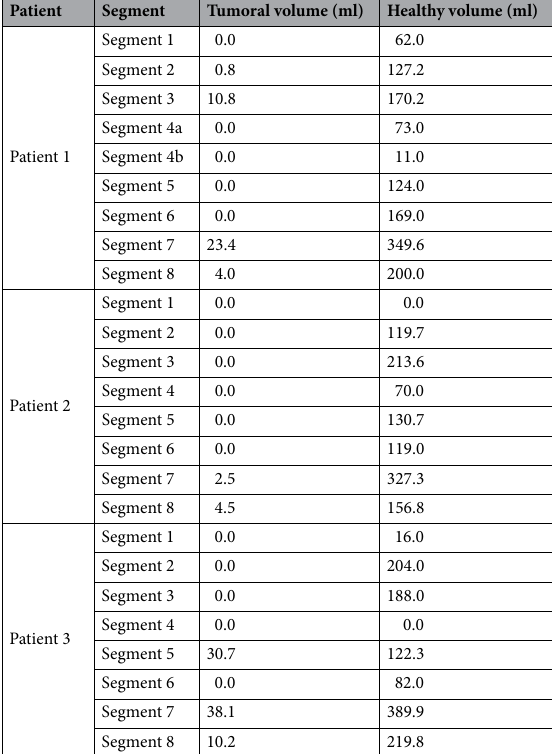
Table 1. Tumoral and healthy volume distribution for each of the three